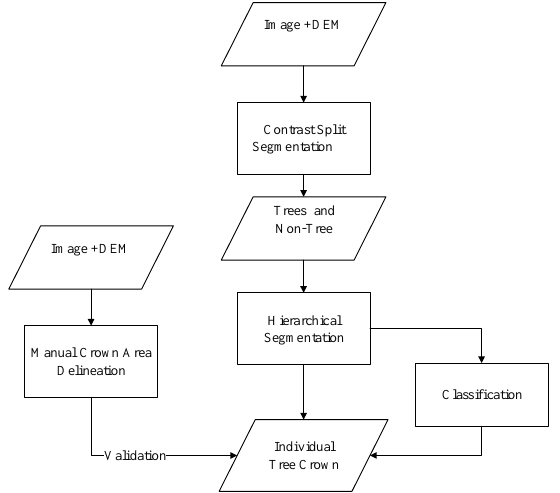
Figure 6. Segmentation and ITC Classification Workflow